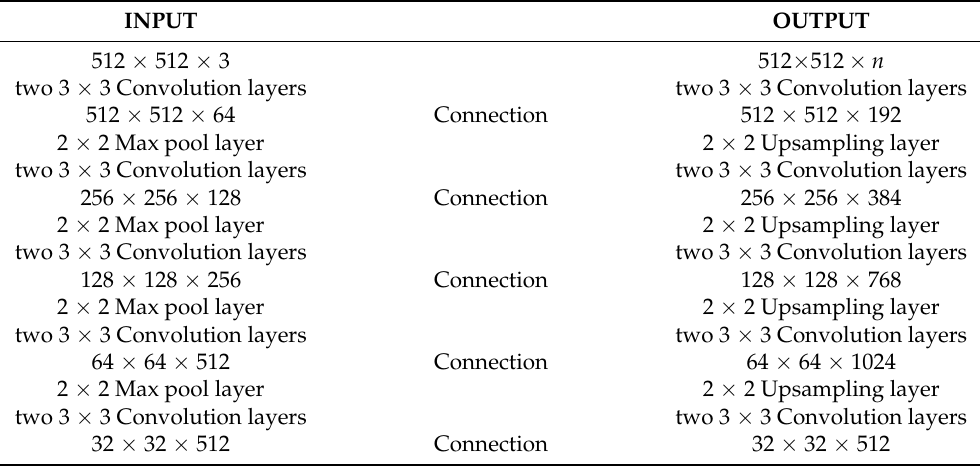
Table 1. Architecture of the proposed model. INPUT